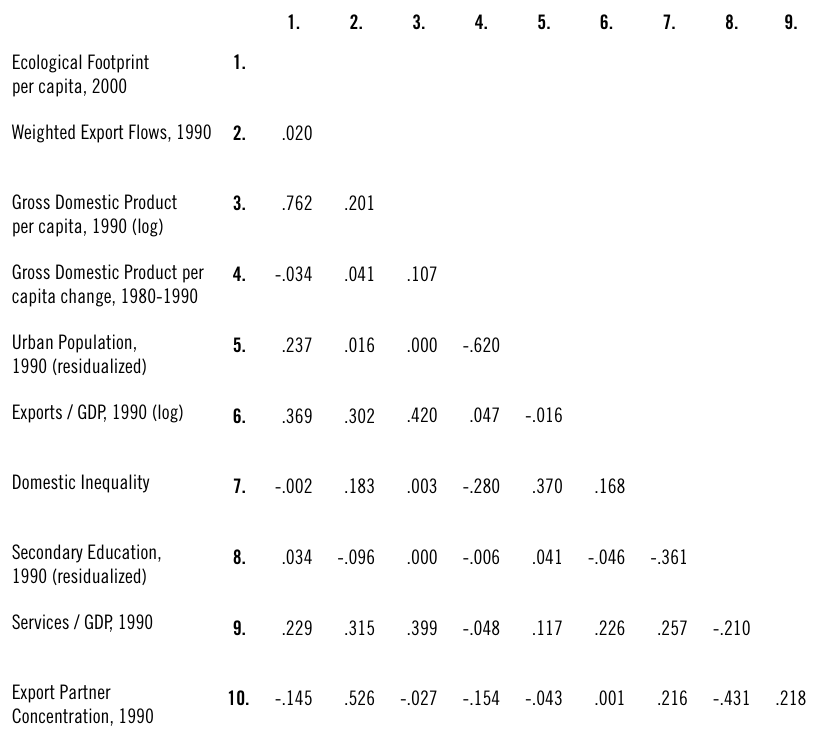
Table 3 – Standardized Coefficients for Analyses of Ecological